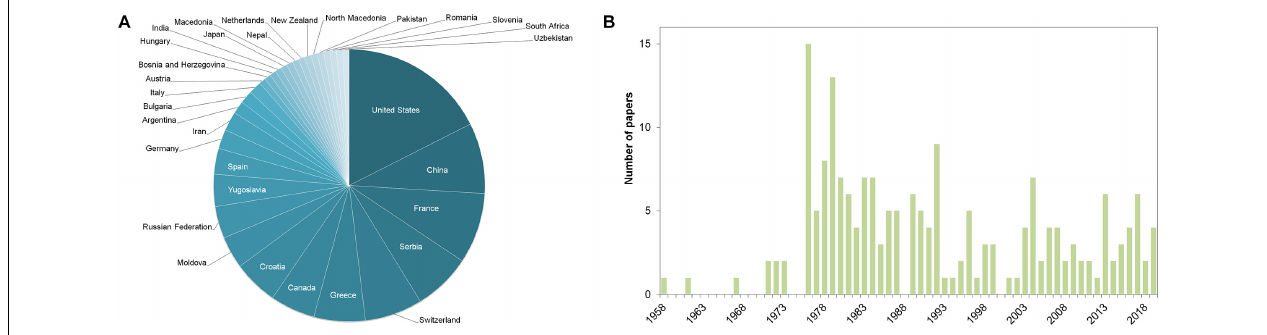
FIGURE 1 | (A) Distribution of the country of origin of the institutions that published research based on hail suppression activities between 1958 and 2019. (B) Temporal evolution of the number of articles published between 1958 and 2019. The criterion for the selection of these studies is described in section “Current Trends and